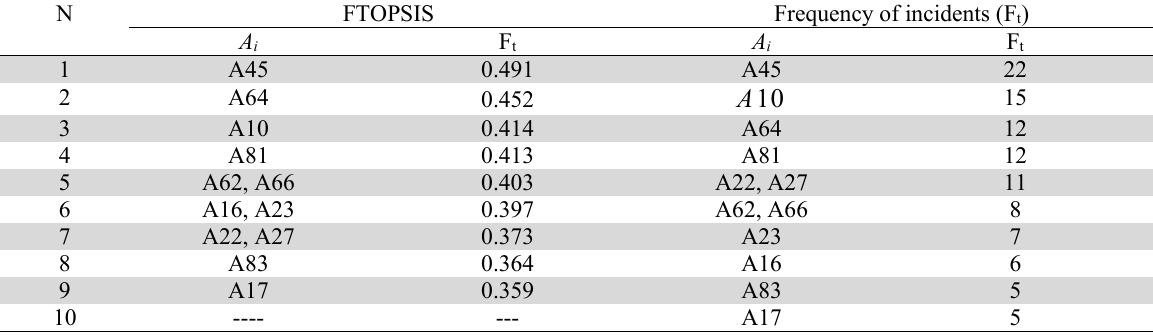
The results of the implementation of FTOPSIS for ranking 21 alternatives based on horizontal